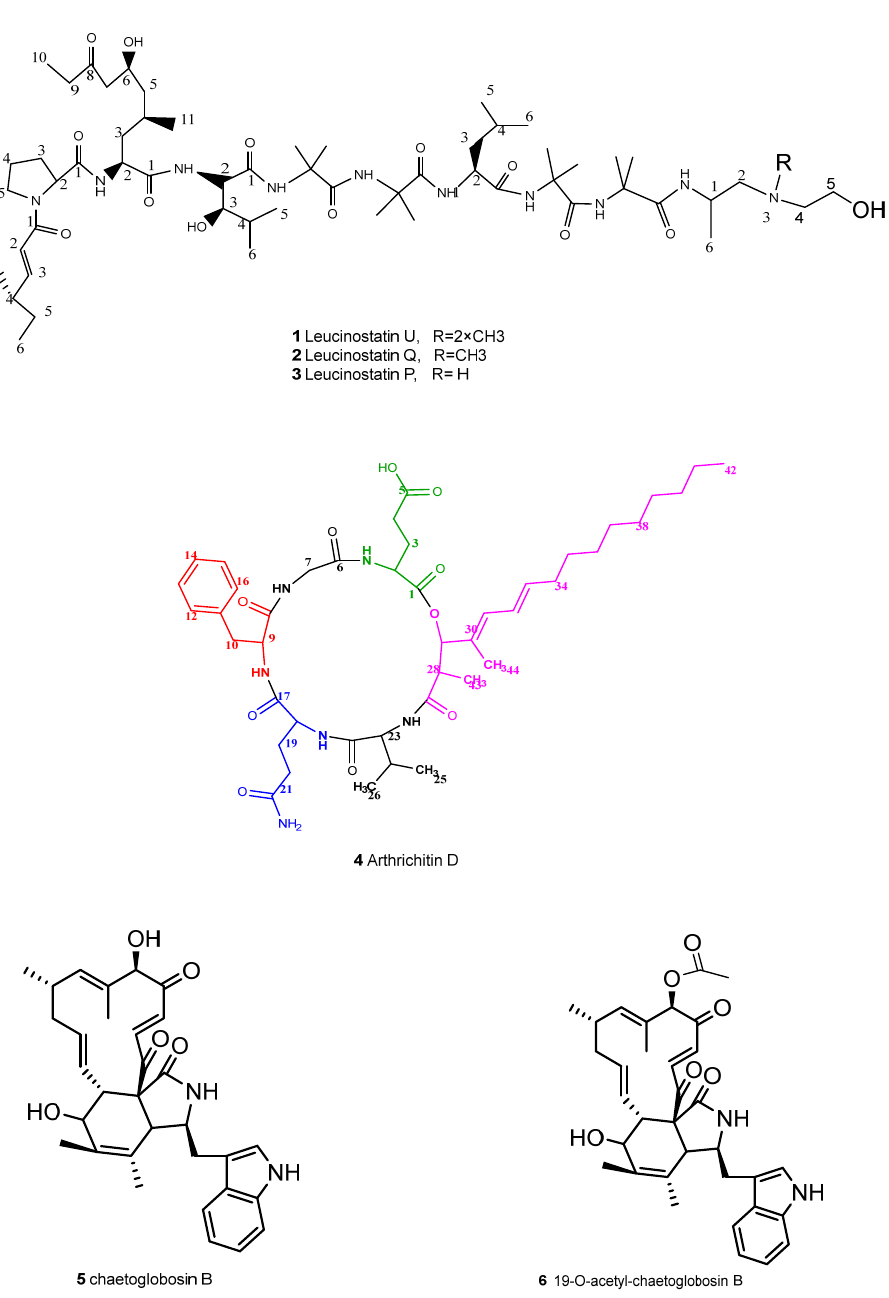
Figure 1. Chemical structures of the metabolites isolated from Ijuhya vitellina DSM 104495.